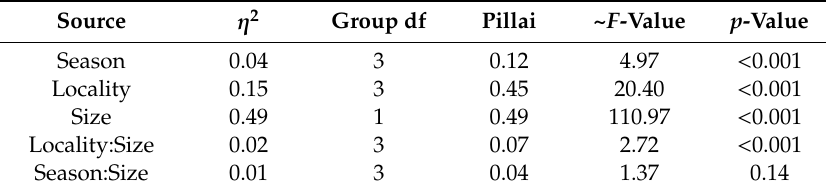
Figure 4. Thin plate spline deformation grids of Eurycea sosorum showing transformations from low to high principal component (PC) factor scores modeled at two standard deviations below and above the mean value for ( A ) PC 1; ( B ) PC 2; ( C ) PC 3; ( D ) PC 4; ( E ) PC 5. Table 1. MANOVA of e ff ects of season, locality, and centroid size (covariate) on head shape variables (i.e., first five principal component factor scores) for Eurycea sosorum